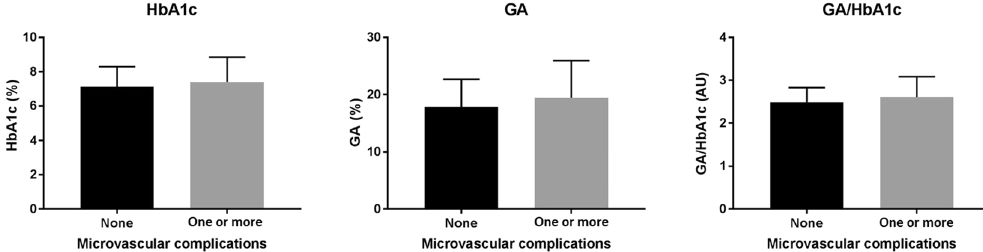
Figure 1. Glycated Serum Protein levels and Microvascular Complications. Statistical comparison of HbA1c, GA and GA/HbA1c ratio between a non-complication group and a complication group. Error bars represent standard deviation.